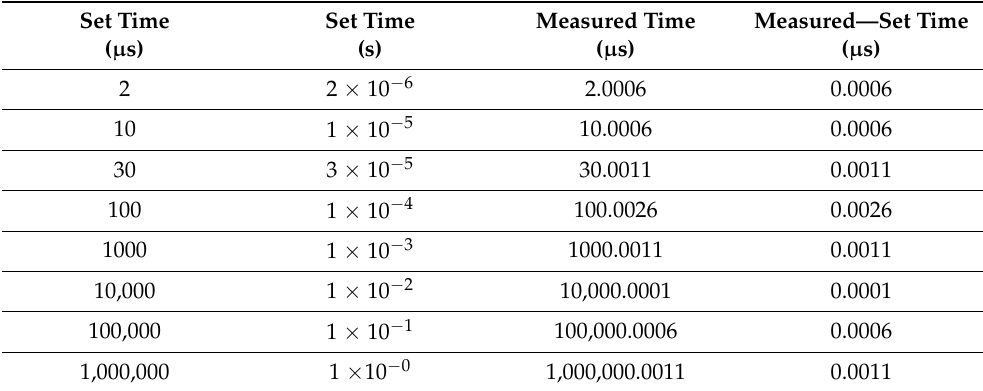
Table 7. Measurement results with counter output and clamper circuit as microcontroller clock sig- nal.